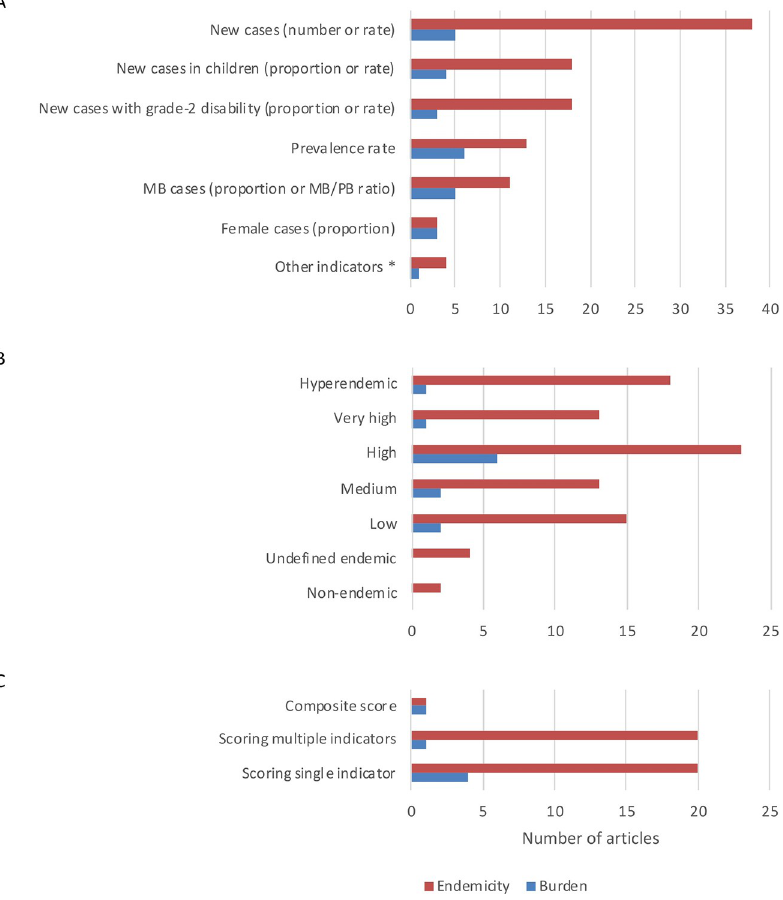
Fig 2. Indicators (A), classification levels (B) and scoring methods (C) used to classify endemicity and burden of leprosy. The bars represent the number of articles that used a particular indicator, classification level, or scoring method to classify endemicity (red) or burden (blue). An article could mention multiple indicators and classification levels. Other indicators include cure rate (2; endemicity), new cases with dimorphic clinical form (2; endemicity), trend in proportion of new cases with a single lesion at time of diagnosis (1; endemicity), and prevalence/detection ratio (1; burden).